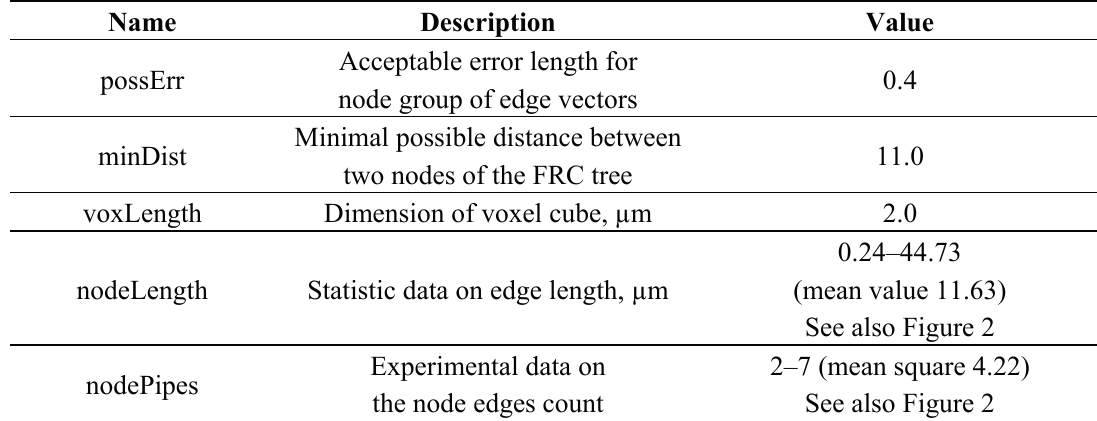
Table 1. The parameters of the algorithm for generating the fibroblastic reticular cell (FRC)